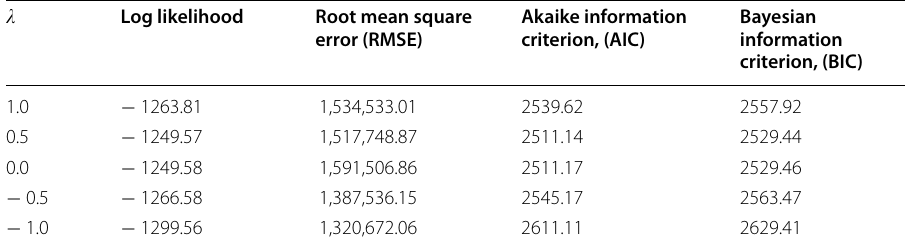
Table 2 Power transformation for Z